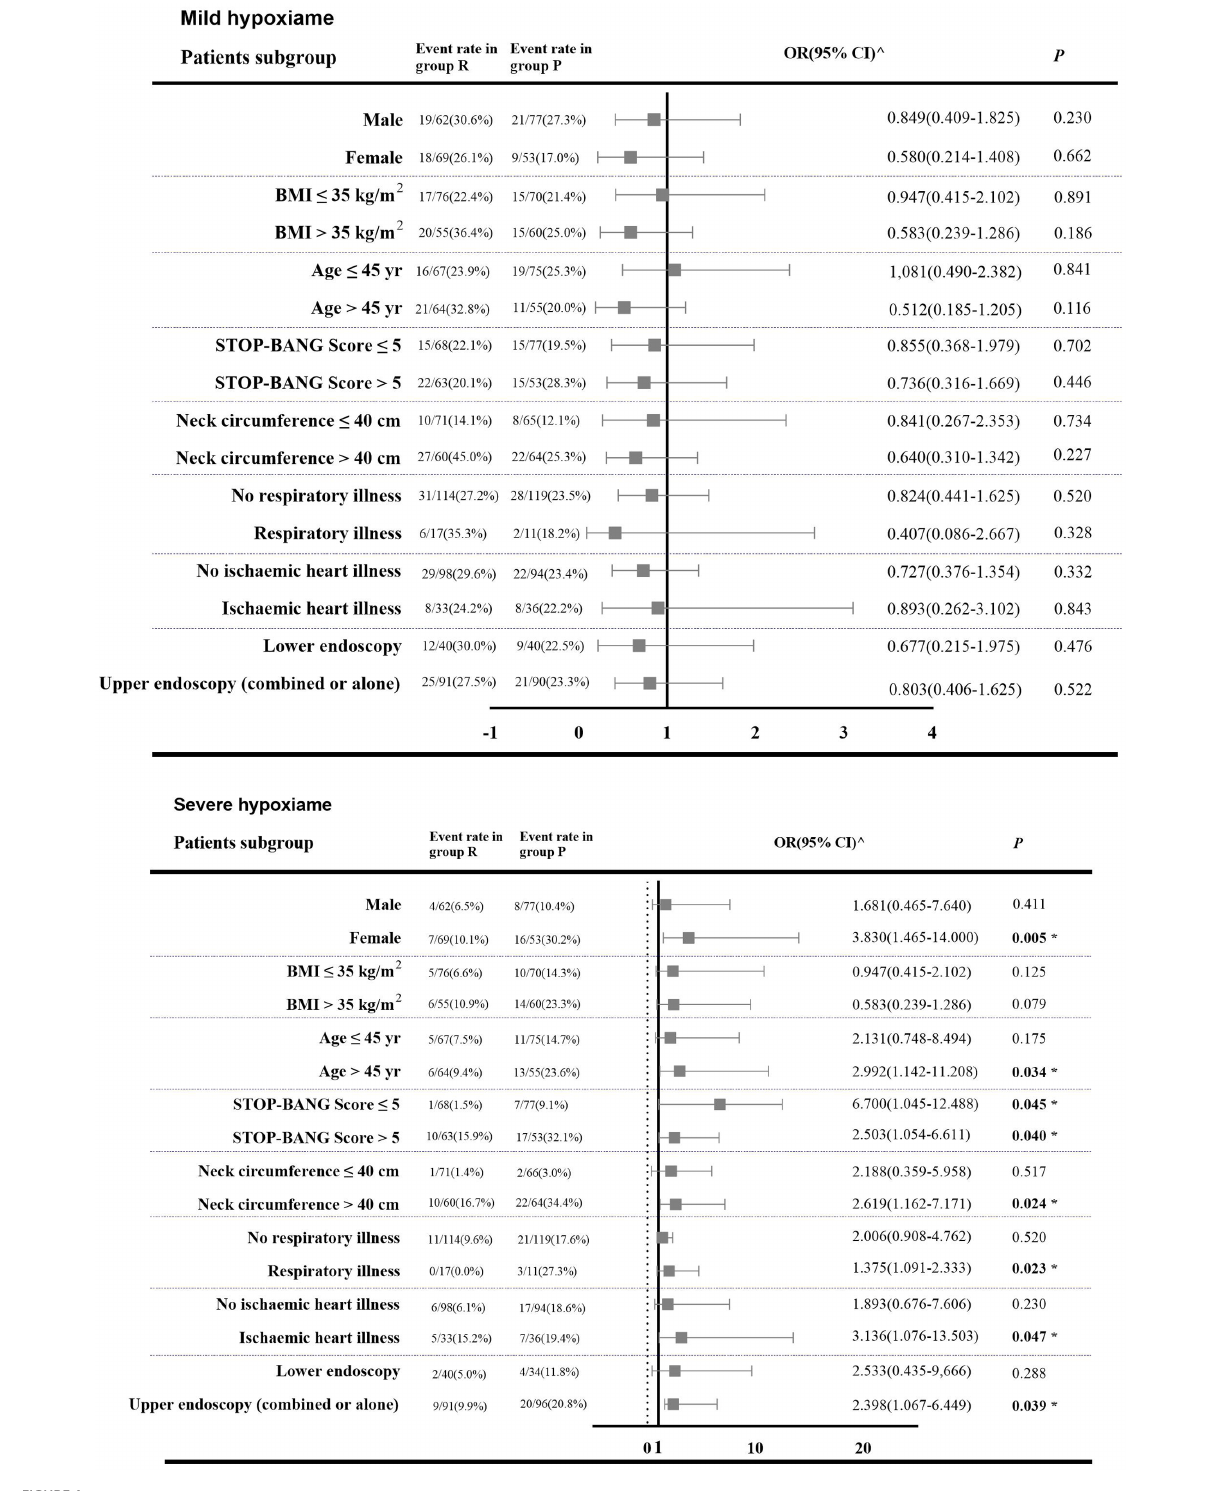
FIGURE 4 Forest plot showing odds ratiao in the occurrence of hypoxemia in subgroups of patients in both intervention groups. 1. Group R = propofol + esketamine group; Group P = remimazolam + esketamine group; 2. BMI (body mass index) is the weight in kilograms divided by the square of the height in meters; 95% CI (95% confidence interval). 3. ^: The number of outcome events in these patient categories is too small so that bootstrapping and logistic regression are not feasible; OR (95% CI) were obtained from Mantel–Haenszel (MH) estimates (21). 4. The p -values of some cases were obtained by the Fisher’s exact test. 5. *: A two-tailed test p < 0.05 was considered statistically